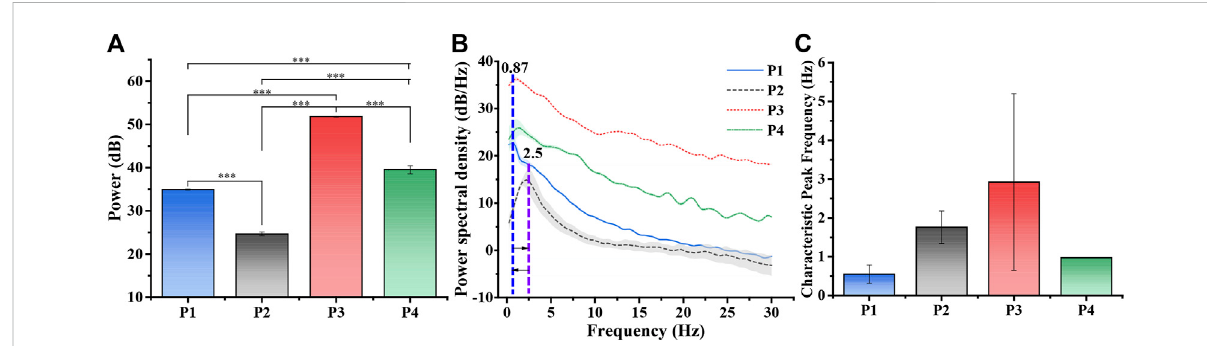
FIGURE 4 Power analysis of LFPs at different periods. (A) LFPs power statistics in different periods (n = 4, one-way repeated measures ANOVA, * p < 0.05, ** p < 0.01, *** p < 0.001, P1: control, P2: torpor, P3 arousal, P4: euthermia). (B) The average PSD varied with frequency in P1-P4 (n = 4). The blue, purple and orange lines represented 0.87 Hz, 2.5 Hz, which displayed a cycle of characteristic peak frequency varied with entering torpor. (C) The average characteristic peak frequency.